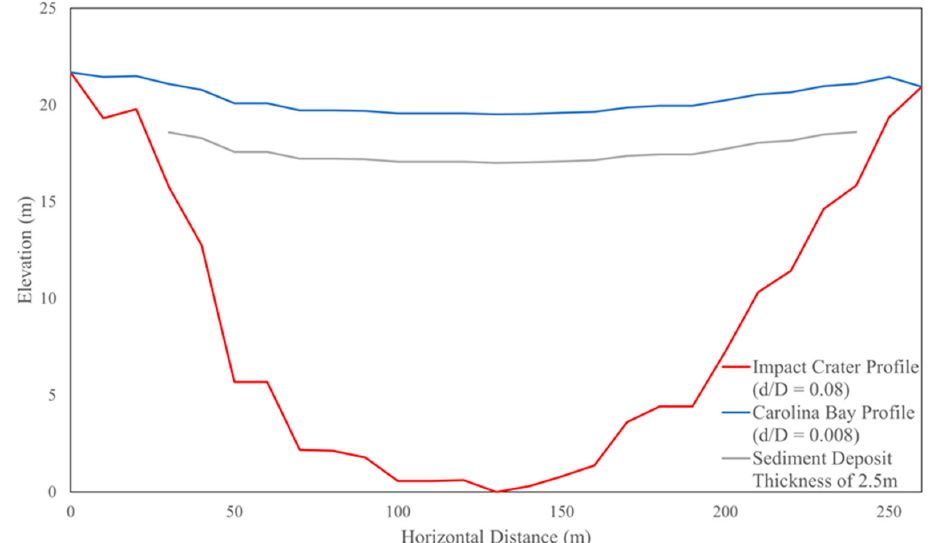
Figure 25. Comparing a Carolina Bay elevation profile with a hypothetical impact crater elevation profile. The sediment deposit thickness curve is plotted to show how much basin sediment fill has occurred in the Carolina Bay since its formation.